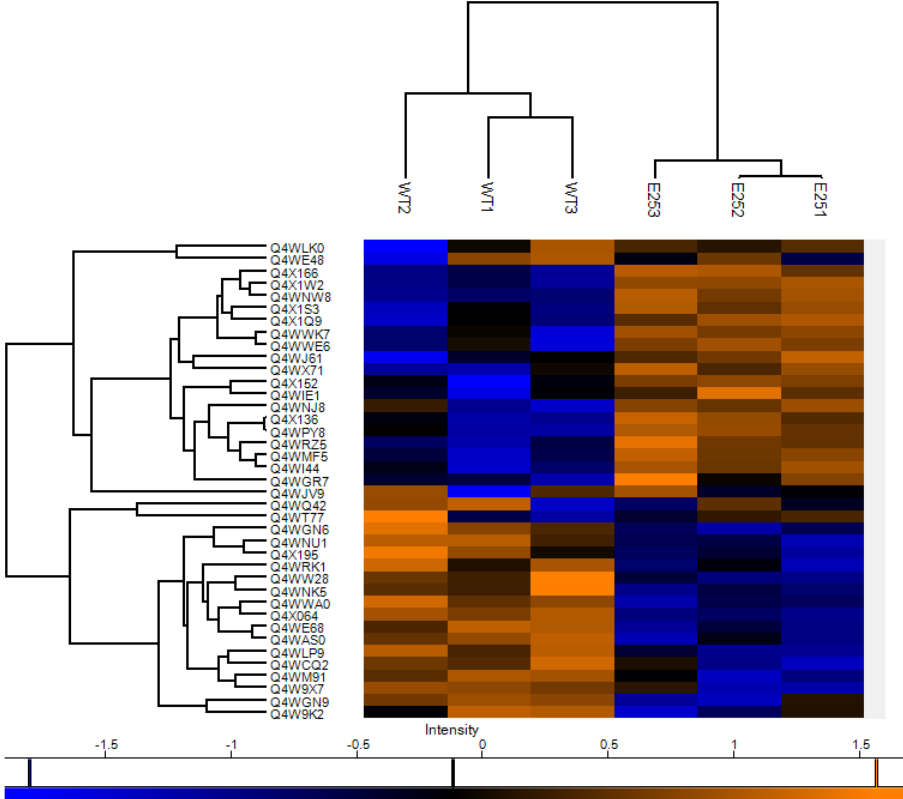
Figure 4. Heat map showing protein clustering between control and passaged A. fumigatus strain E25. Shotgun quantitative proteomic analysis of passaged strain and control mycelia grown in Czapex– Dox broth for 72 h. Two-way unsupervised hierarchical clustering of the median protein expression values of all statistically significant differentially abundant proteins. Hierarchical clustering (columns) identified two distinct clusters comprising the three replicates from their original sample groups.